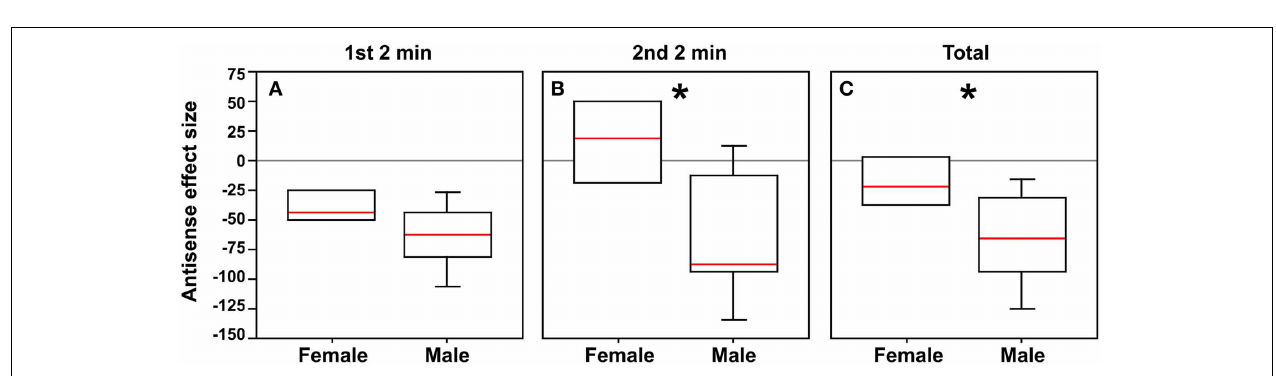
social contact in females in the first 2min of testing ( p = 0 . 04), but not in the second 2min of testing ( p = 0 . 54). (F) With the first and second test periods combined, there is no overall effect on social contact in females ( ∗ p = 0 . 46). Data are shown as post-treatment minus pre-surgical values. Box plots show the median (red line), 75th and 25th percentile (box), and 95% confidence interval (whiskers).